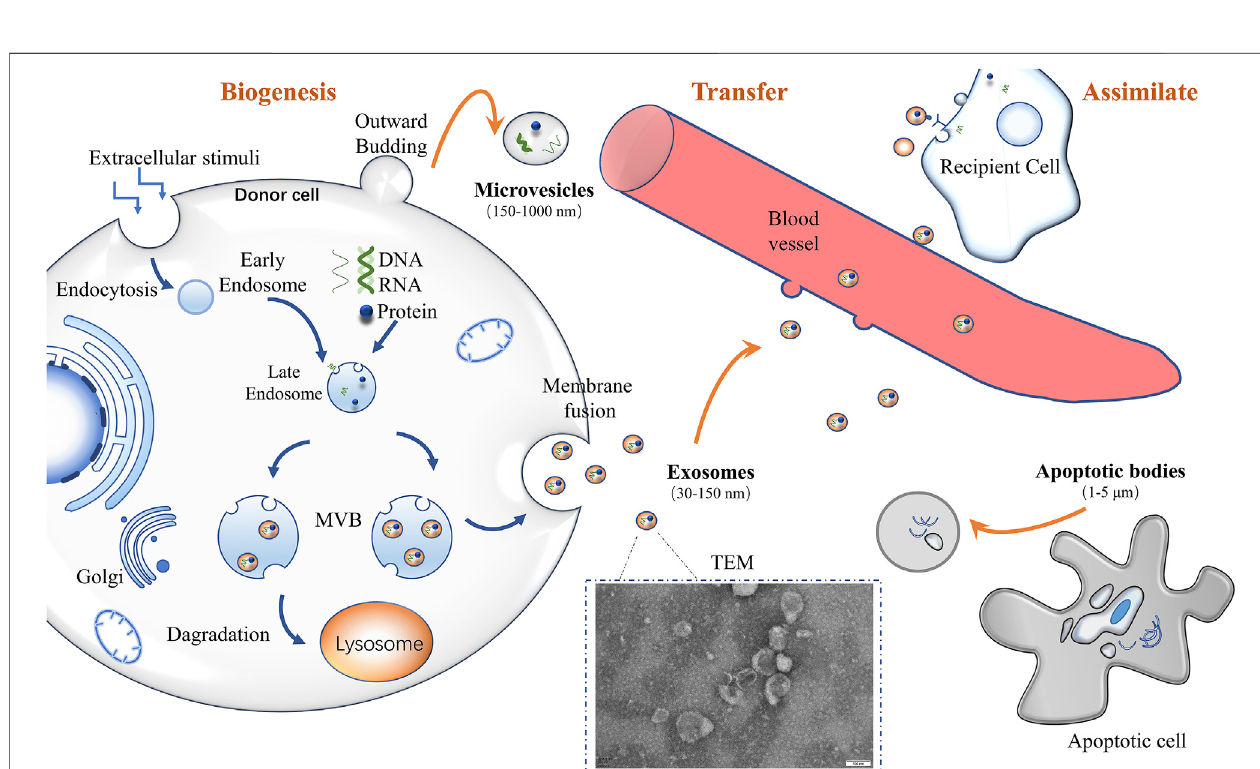
FIGURE 2 | Biogenesis of exosomes and other vesicles (Hessvik and Llorente, 2018) (van der Pol et al., 2012) (Gurunathan et al., 2019).